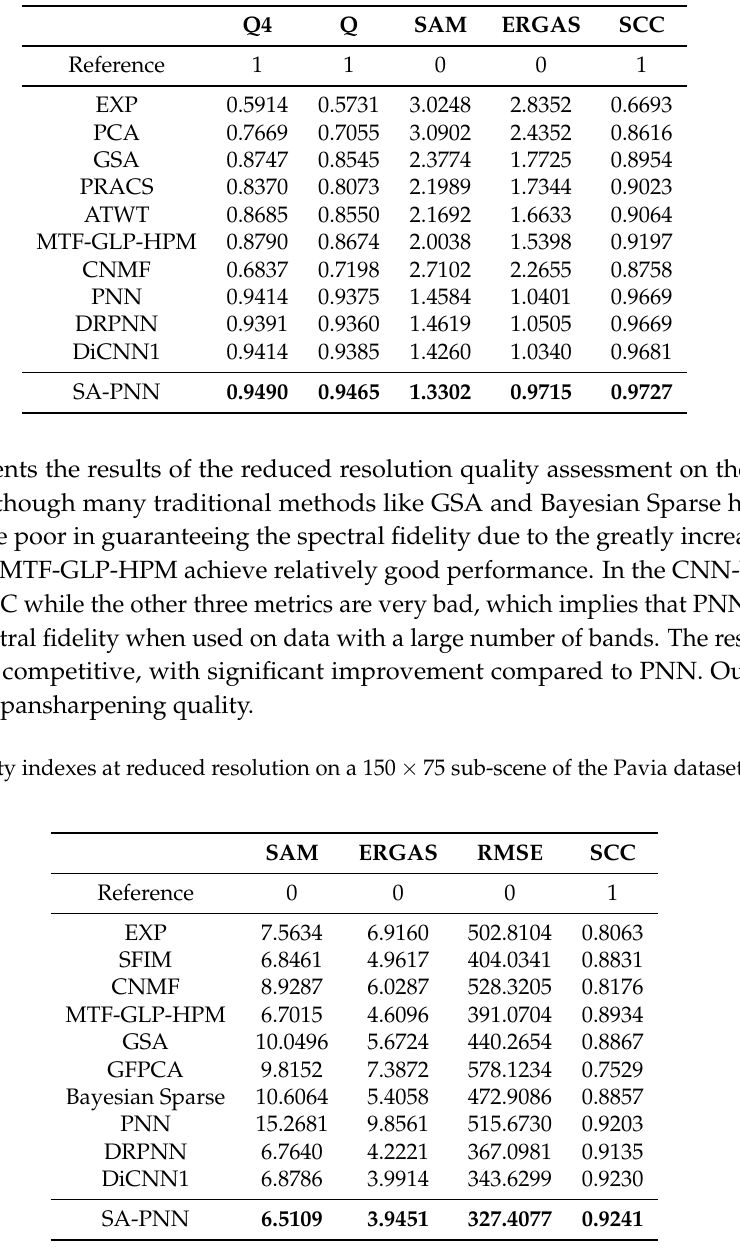
Table 4. Quality indexes at reduced resolution on a 256 × 256 sub-scene of the Quickbird dataset (best result is in bold).